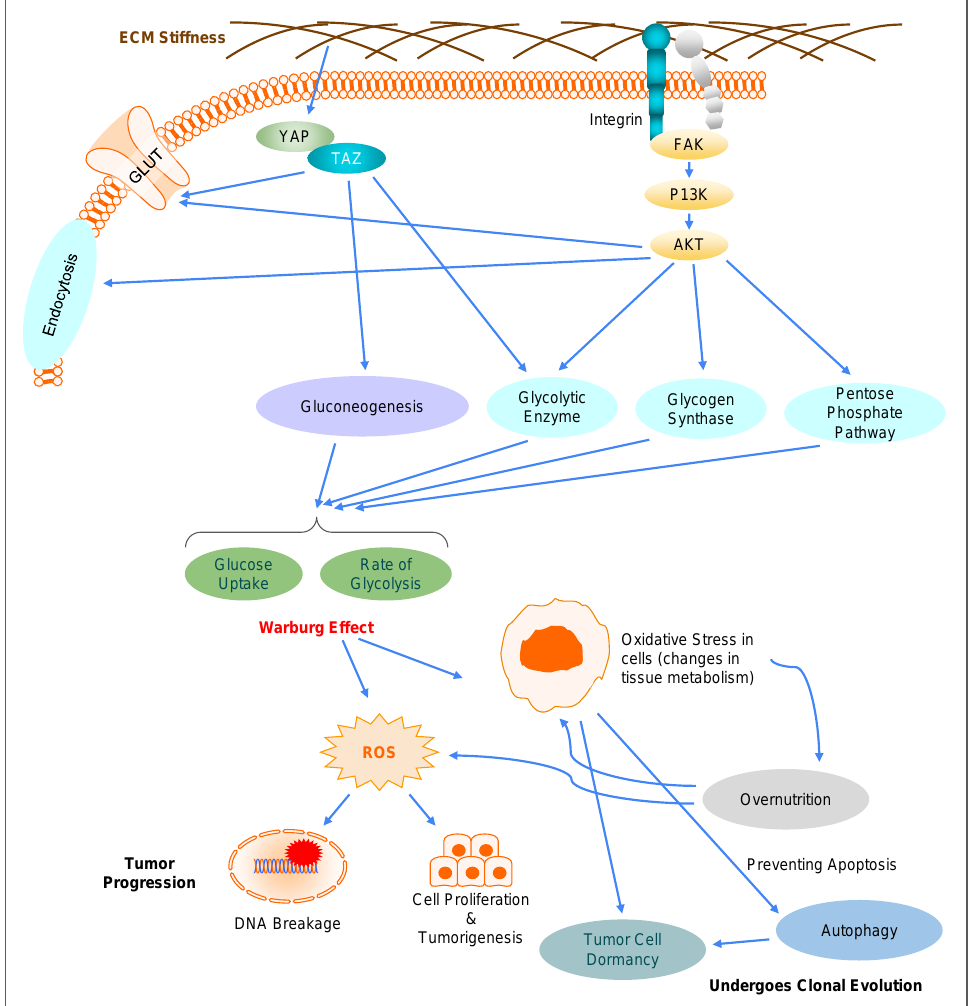
Figure 4. Involvement of mechanotransduction in metabolism reprogramming and cancer cell evolution/clonal selection. Alterations in ECM stiffness influence the glucose metabolism in cancer cells through mechanotransduction. Activation of the YAP/TAZ and integrin-FAK-P13K-AKT path- ways can enhance glucose uptake and glycolysis via endocytosis, glucose transportation by GLUT, gluconeogenesis, activation of glycolytic enzymes or glycogen synthase, and upregulation of the pentose phosphate pathway. Due to the Warburg effect in cancer cells, active glycolysis can generate ROS and free radicals, leading to oxidative stress, which in turn can change cellular metabolism into a cycle of overnutrition. On the other hand, ROS can cause DNA breakage and genome instability, which serves as a driving force for uncontrolled cell proliferation, and tumorigenesis. Oxidative stress also leads to autophagy and cancer dormancy, where autophagy aids the survival of dormant cancer cells and allows cancer cells to undergo clonal